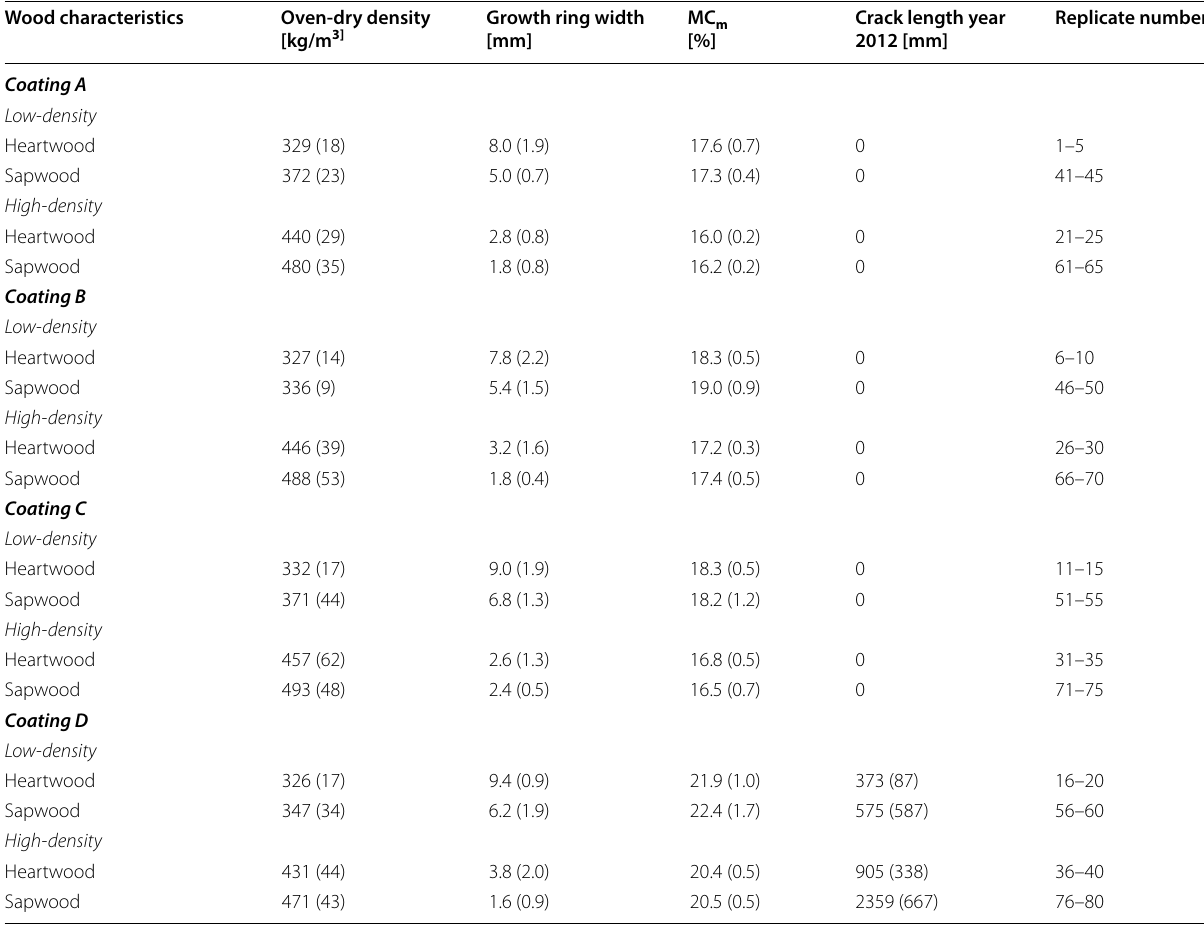
and crack length m